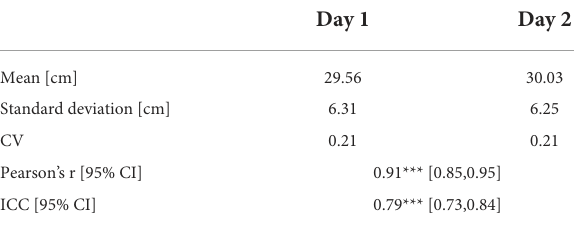
TABLE 3 Descriptive statistics and correlations of the day-to-day comparison between the CMJ-height measured by Polar Vantage V2 sports watch on two consecutive